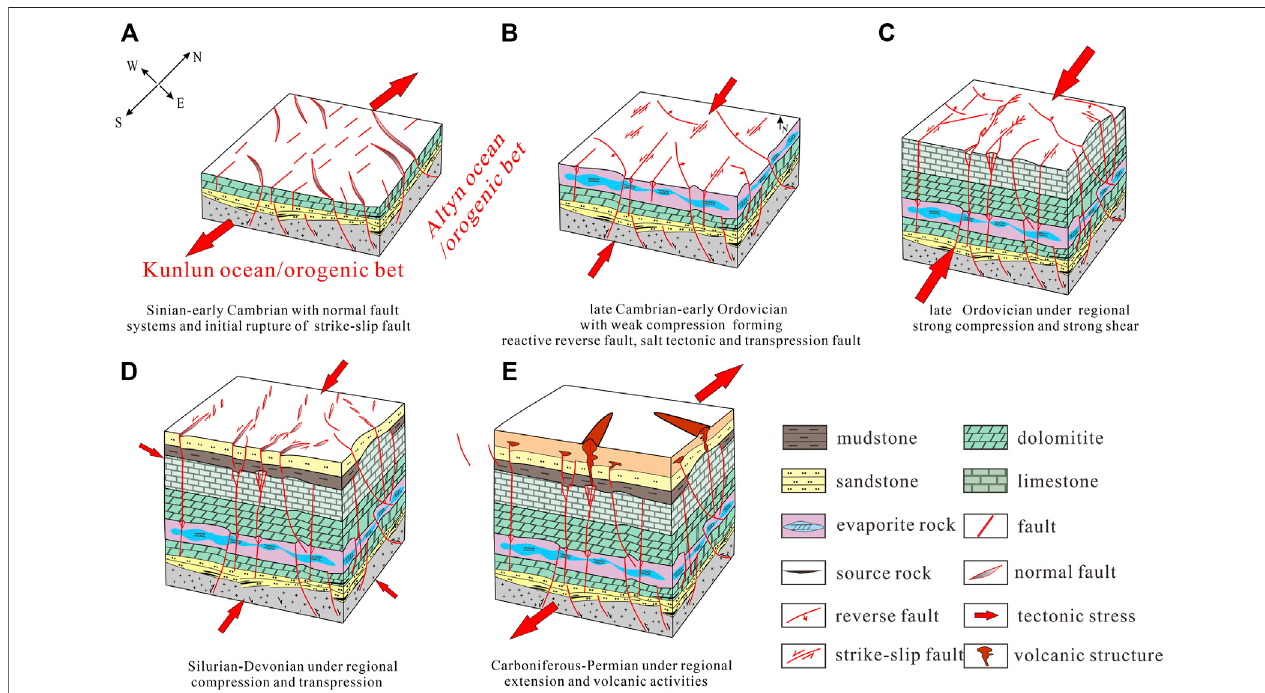
FIGURE 14 | Evolution model of the strike-slip fault system of the Tazhong uplift: (A) fault evolution stage in the Sinian – Early Cambrian, (B) fault evolution stage in the LateCambrian – EarlyOrdovician, (C) faultevolution stage intheLate Ordovician, (D) fault evolutionstage in theSilurian – Devonian, and (E) fault evolutionstage in the Carboniferous –